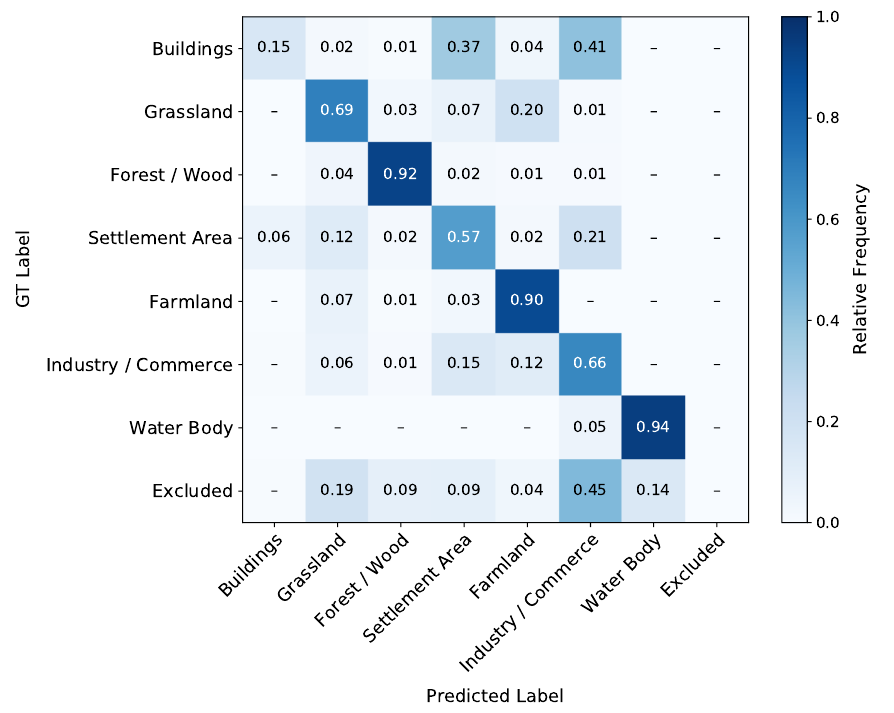
Figure 10. Normalized confusion matrix for the best-scoring ensemble of LSTM F models. The pre- diction is performed with the six sequences of the 2018 data using the introduced voting scheme and compared to the GT. Note that, compared to the 2016 classification in Figure 8, confusions can also originate from changes in the land cover between 2016 and 2018.